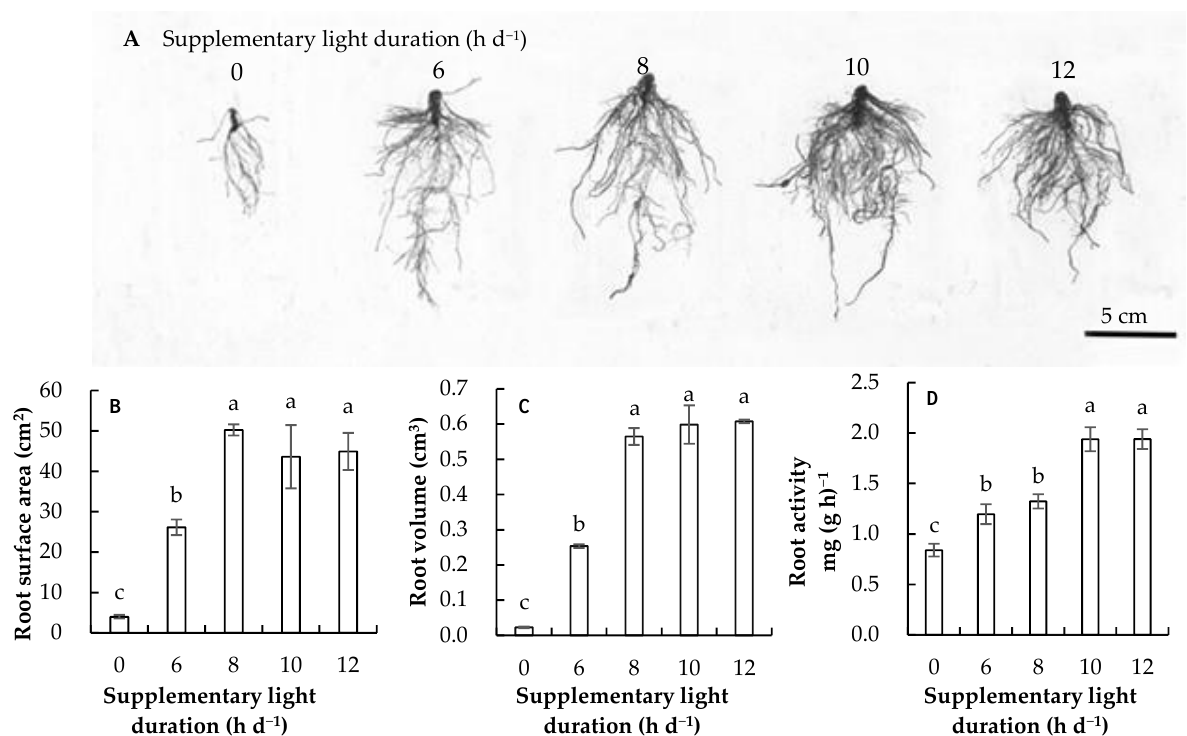
Figure 3. Effects of supplementary light duration with same daily light integral on root morphology and root activity of cucumber seedlings grown in the greenhouse for 21 days after sowing. ( A ) One representative picture was shown for each treatment, ( B ) root surface area, ( C ) root volume, and ( D ) root activity. Means followed by different letters within each parameter are significantly different based on the least significant difference (LSD) test ( p < 0.05). Error bars show mean ± standard